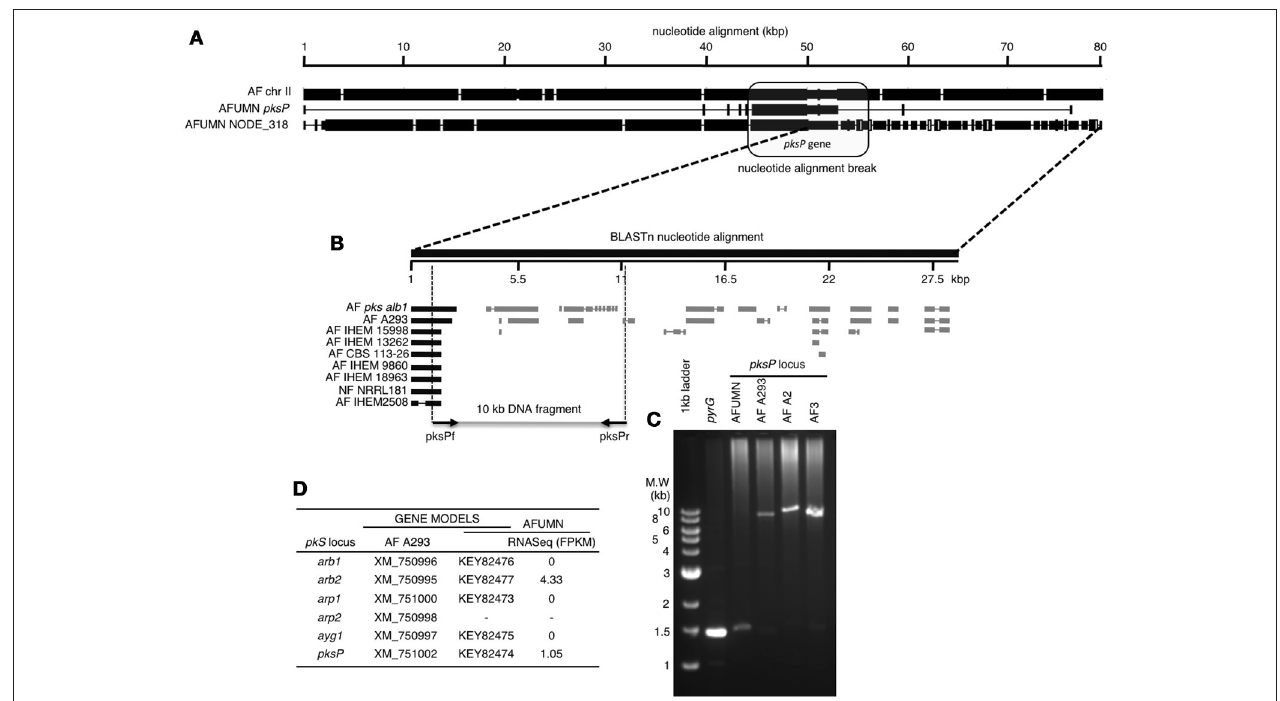
FIGURE 3 | Nucleotide alignment of A. fumigatus var. niveus contig NODE_318, the pksP cluster and the corresponding region of A. fumigatus Af293 chromosome II. (A) In A. fumigatus var. niveus the pksP cluster is interrupted by non- Aspergillus DNA sequences. Closed and open boxes indicate nucleotide agreement and disagreement respectively, while interruptions indicate gaps (or deletions). In the initial 40kb of the alignment there are 11 base-pair changes (deletion, insertion or base-pair change) while after the 50kb mark the DNA sequence changes completely suggesting insertion of a foreign DNA or translocation. (B) Alignment of NCBI-nr fungal DNA with the conflicting terminal region of A. fumigatus var. niveus pksP cluster. The 27.5kb DNA sequence initiating at the breakpoint in (A) (internal to the pksP cluster) was BLASTn aligned with all NCBI fungal DNA sequences and matches indicated by closed boxes ( pksP ) or gray boxes when aligning to other non-chromosome II DNA sequences. Empty spaces indicate DNA sequences not preset in NCBI-nr database. (C) PCR amplification of a 10kb genomic DNA region surrounding the homology break in the pksP alignment in A. fumigatus var. niveus (AFUMN) and three Aspergillus fumigatus (AF293, AFA2, and AF3) strains. (D) The A. fumigatus (A293) pksP cluster genes contains six genes ( arb1 , arb2 , arp1 , arp2 , ayg1 , and pksP ) one was not found in AFUMN four appear not to be transcribed in AFUMN and two showed baseline transcription levels.